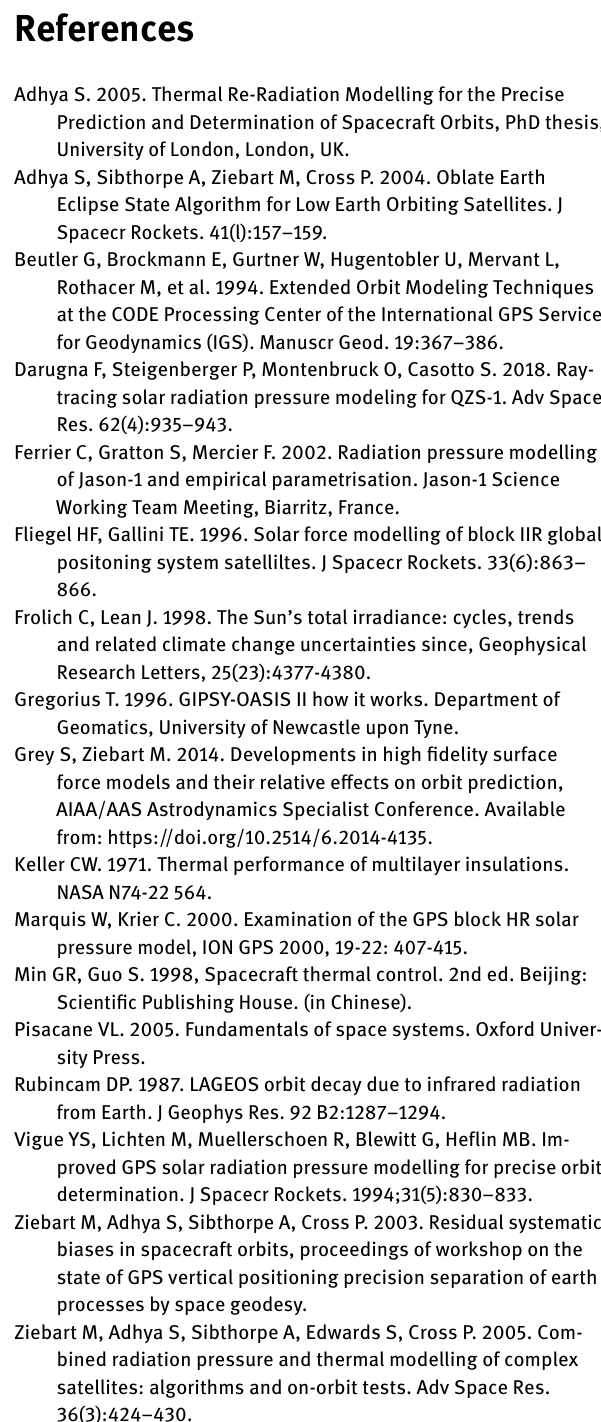
Table 6. GPS Block IIR solar panel temperature